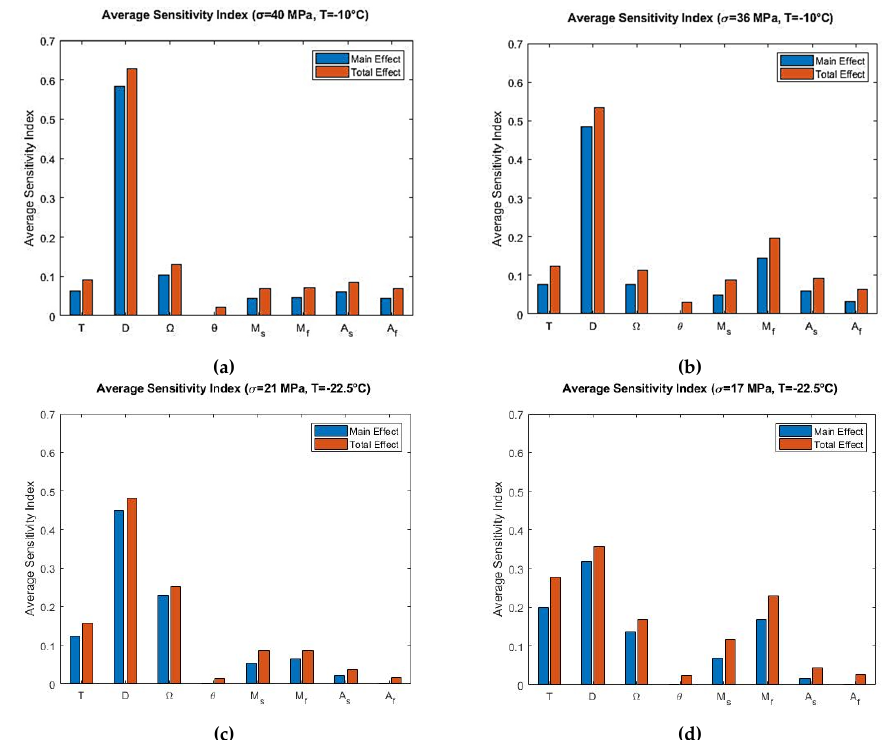
Figure 10. eFAST average sensitivity indices at simulated temperatures and maximum loading stress for the Liang-Rogers model: ( a ) 𝑇 = −10°𝐶,𝜎 (cid:3040)(cid:3028)(cid:3051) = 40 MPa; ( b ) 𝑇 = −10°𝐶,𝜎 (cid:3040)(cid:3028)(cid:3051) = 36 MPa; ( c ) 𝑇 = −22.5°𝐶,𝜎 (cid:3040)(cid:3028)(cid:3051) = 21 MPa; ( d ) 𝑇 = −22.5°𝐶,𝜎 (cid:3040)(cid:3028)(cid:3051) = 17 MPa. ( c ) T = − 22.5 ◦ C, σ max = 21 MPa; ( d ) T = − 22.5 ◦ C, σ max = 17